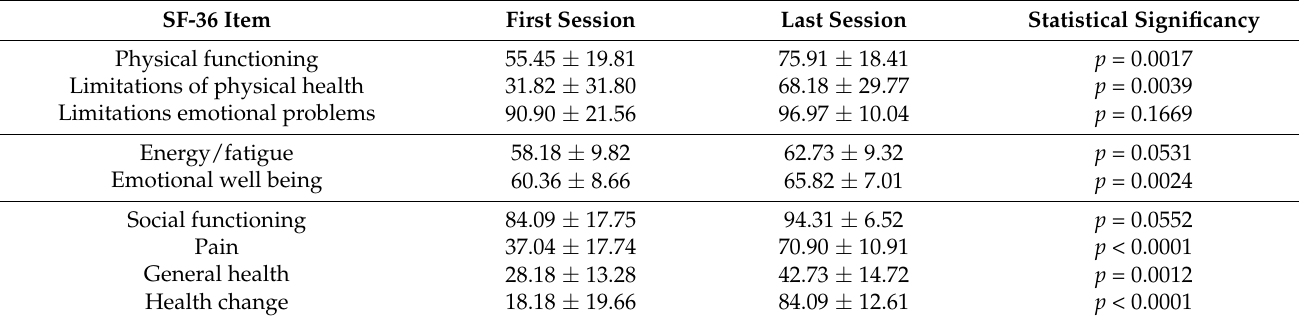
Table 6. KiOil group SF-36 questionnaire